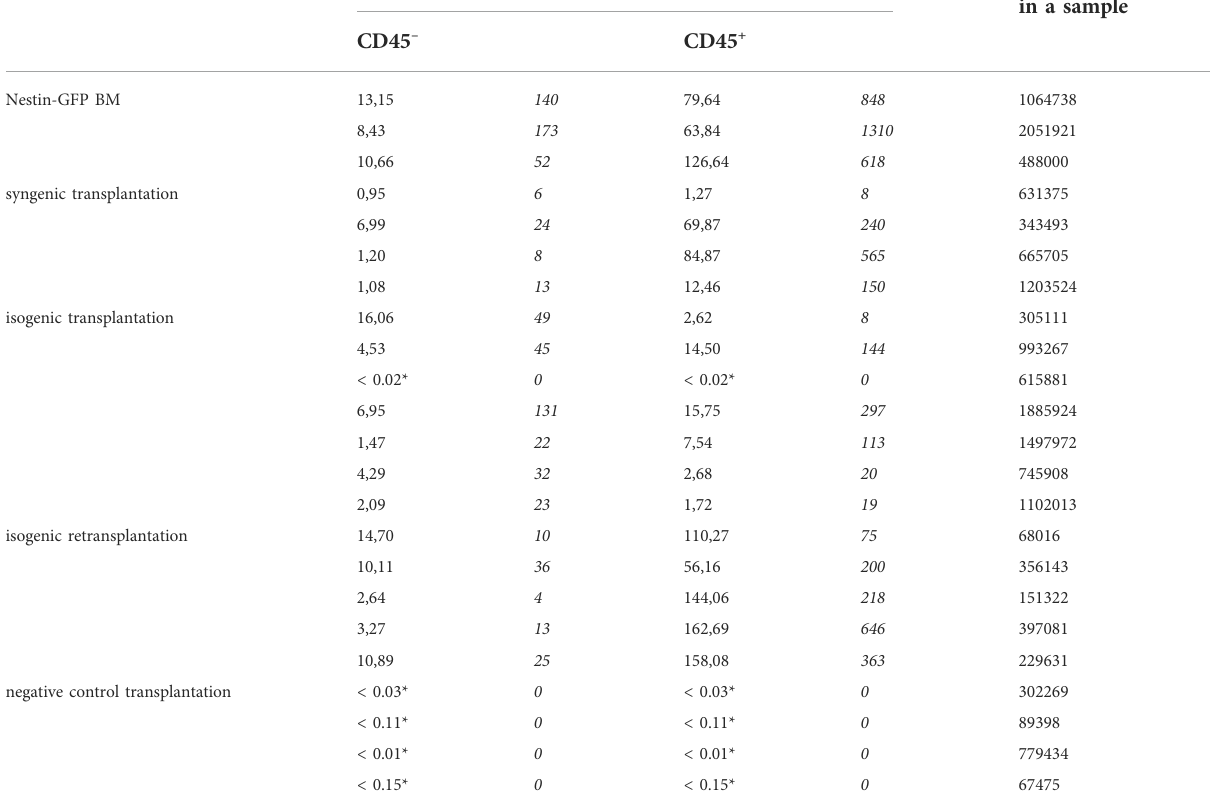
TABLE 1 Characteristics of individual samples of experimental groups acoording to MFC analysis. * Zero cell counts were transformed into non-zero proportions as described in Materials and Methods to estimiate measurement accuracy.